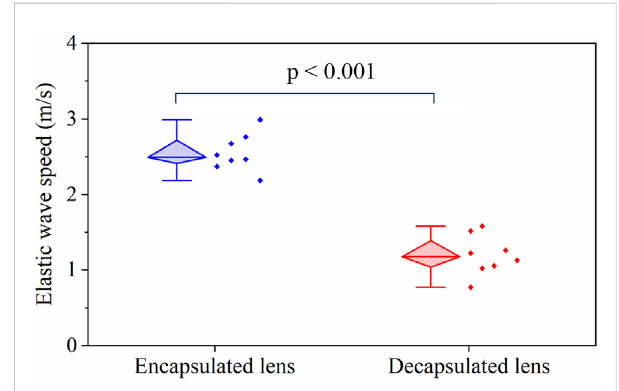
FIGURE 3 A box-whisker plot and measured data set distribution of the elastic group wave speed in the porcine lens before and after removal of capsule for N = 8 porcine lenses. The horizontal bar in the diamond box corresponds to the median of the data.